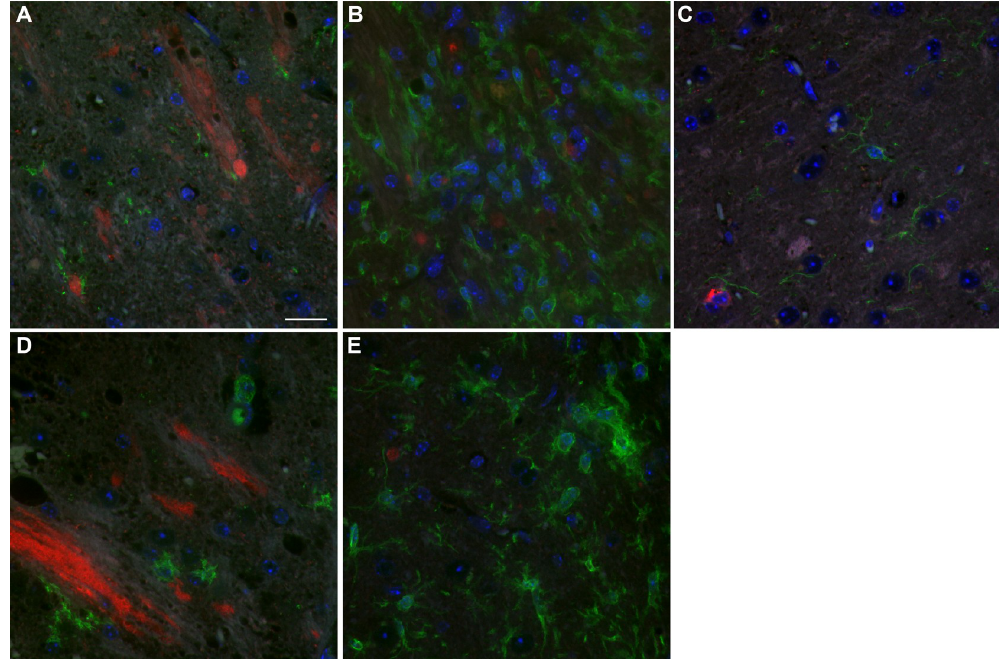
Fig 6. PrP-3F4 does not colocalize with microglia following IC inoculation of Tg3F4 mice with ME7 prions or NBH. PrP-3F4 (red) and Iba1(green) in the hypothalamus of NBH (A and B) or thalamus of ME7 (D and E) inoculated mice 24 hrs (A and D) and 2 weeks (B and E) post inoculation. (C) Thalamus of uninoculated Tg3F4 mouse. PrP-3F4 was detected using a biotinylated form of the anti-PrP mouse monoclonal antibody 3F4. The no primary control is shown in Fig 7C. DAPI stain for nuclei = blue; Scale bar = 20 μ m.